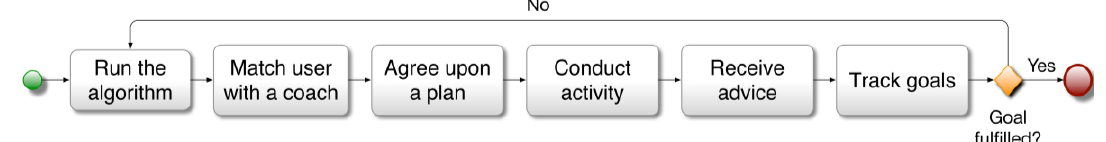
Figure 8. Initial business process